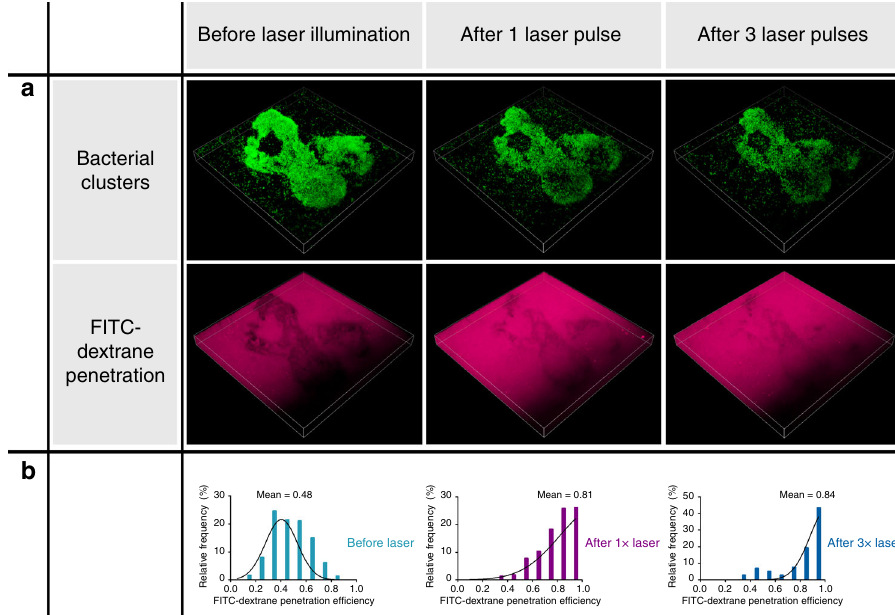
Fig. 7 VNB-formation enhances the penetration of molecules into bio fi lms. a FITC-dextrane 4 kDa penetration in exemplary bacterial cell clusters of P. aeruginosa bio fi lms before and after VNB-treatment. Bacteria are displayed in green, while FITC-dextrane is depicted in magenta. Width = 212 µ m, height = 212 µ m, depth = 18 µ m. b 3-D analysis of FITC-dextrane penetration into a total of 20 clusters ( n = 5 × 4) was quanti fi ed according to Eq. (1). The histograms show that FITC-dextrane penetration was markedly enhanced following 1× or 3× laser treatment